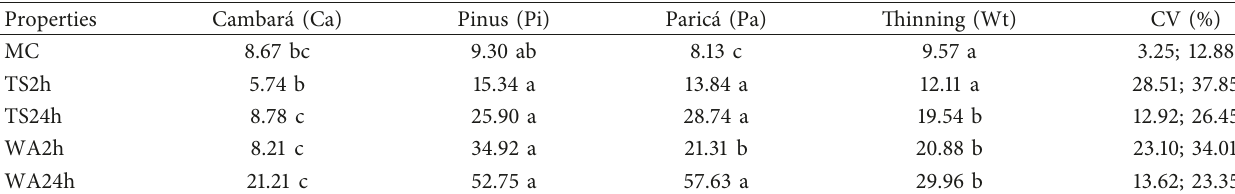
Table 3: Physical property results in